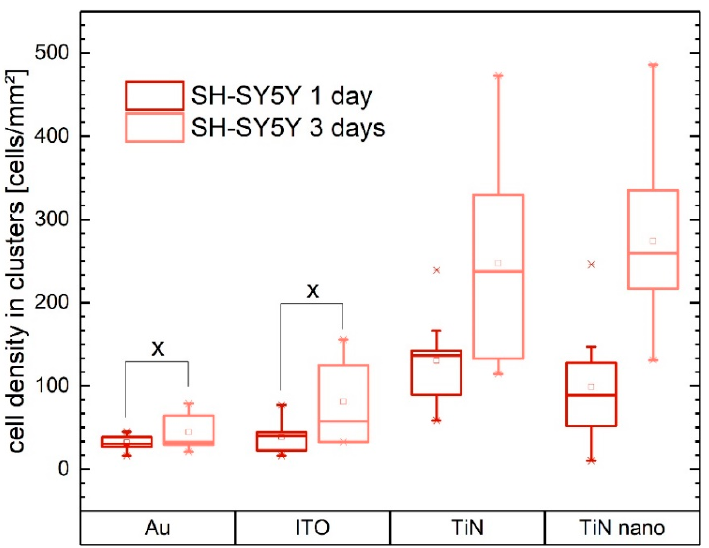
Figure 7. Cell density in clusters of SH-SY5Y cells grown on different electrode materials (Au, ITO, TiN, TiN nano) after one and three days of growth as a result of K-means clustering. Values marked with X are not statistically significant ( p > 0.05).